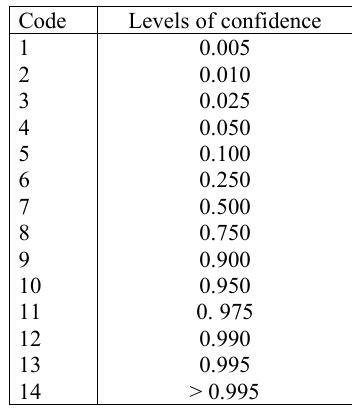
Table 1. Levels of confidence corresponding to the codes assigned by ArcGIS with the soft Bayesian Classifier 2.3 Identification of regions with different levels of uncertainty and confidence